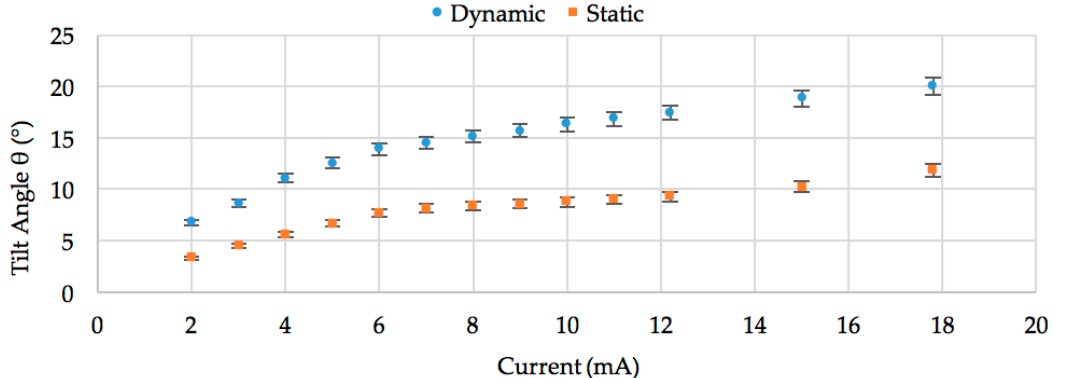
Figure 5. Angle of θ tilt mode vs. current. Red squares show the tilt angle with dc current, and the blue circles show the tilt angle with ac current of 244 Hz, using configuration of Figure